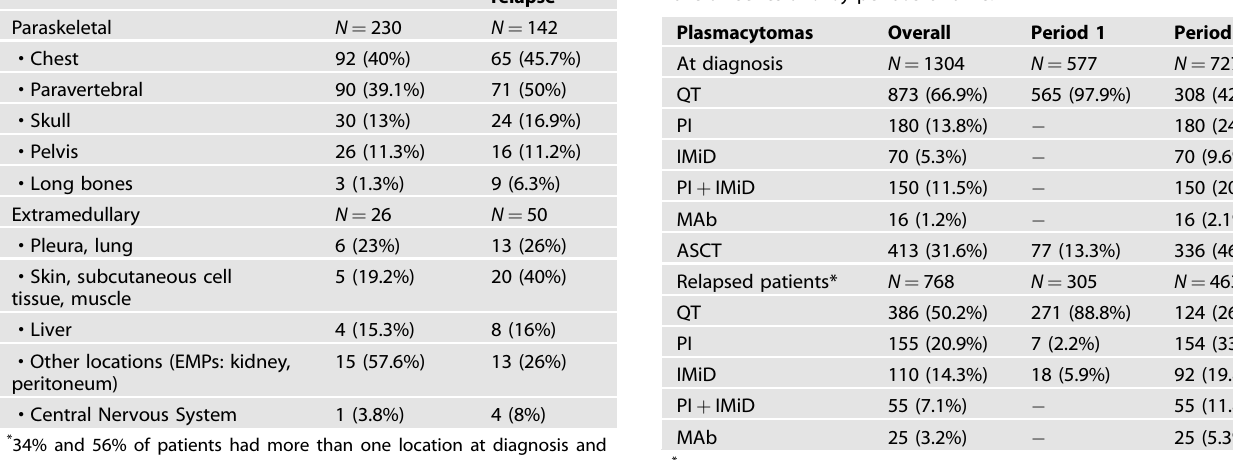
Table 4. Treatment received at diagnosis and at fi rst relapse in the overall series and by periods of